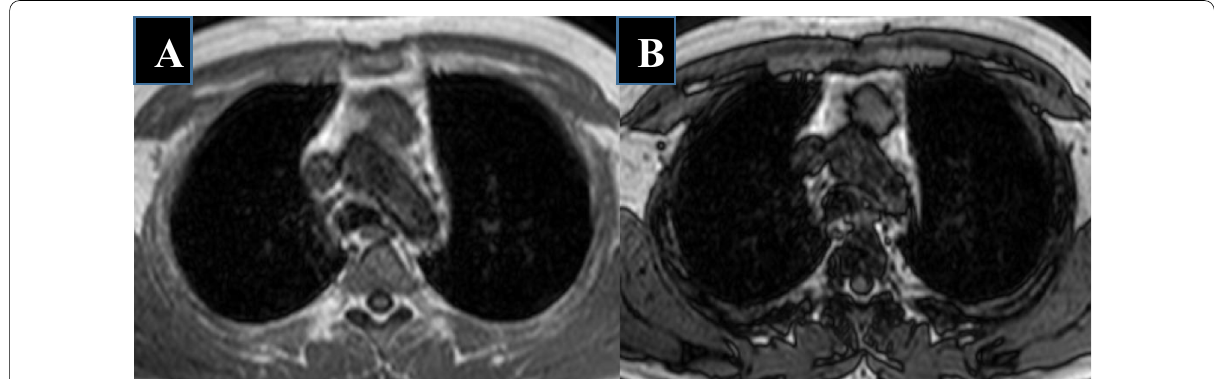
Fig. 3 MRI chemical shift imaging in a 38‑year‑old male patient complaining of weakness in both upper limbs diagnosed as MG. a In phase and b out of phase MR images show the mass eliciting intermediate signal to the surrounding muscles with no apparent signal drop in the out of phase series. CSR value is 1.05. Histopathological diagnosis was thymoma